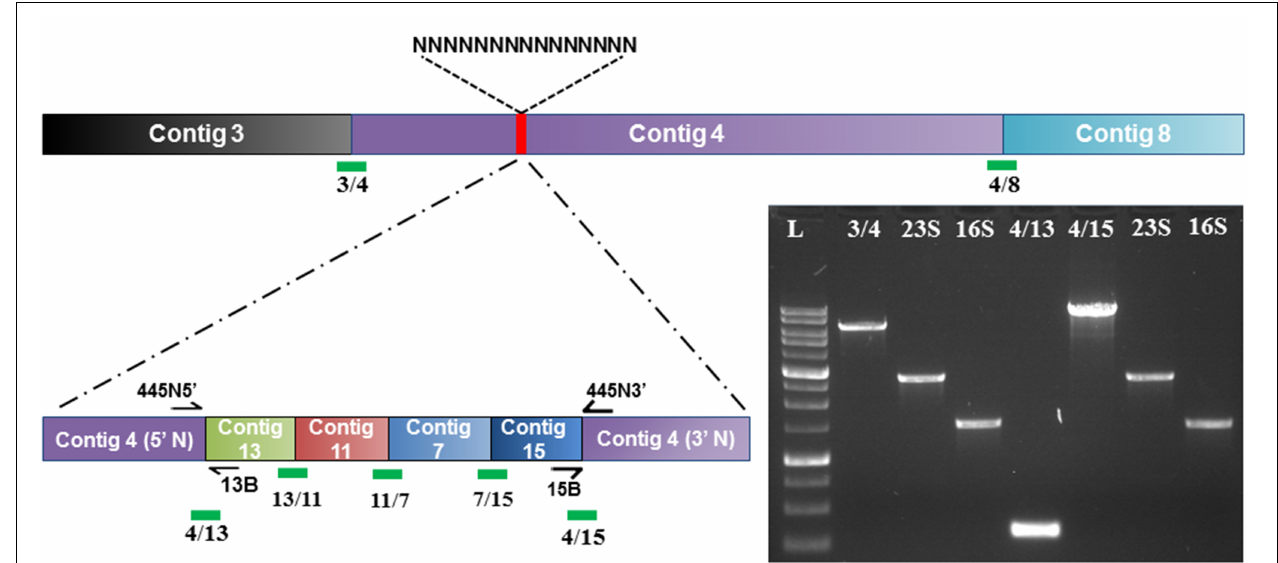
molecular weight ladder, 16S and 23S genes were amplified from the preceding PCR product correspond to the following contig gaps; 3/4 – gap between contig 3 and contig 4, 4/15 – PCR product corresponding to insertion of contig 15 within an ambiguous base stretch of contig 4, 4/13 – PCR product corresponding to insertion of contig 13 within an ambiguous base stretch of contig 4.